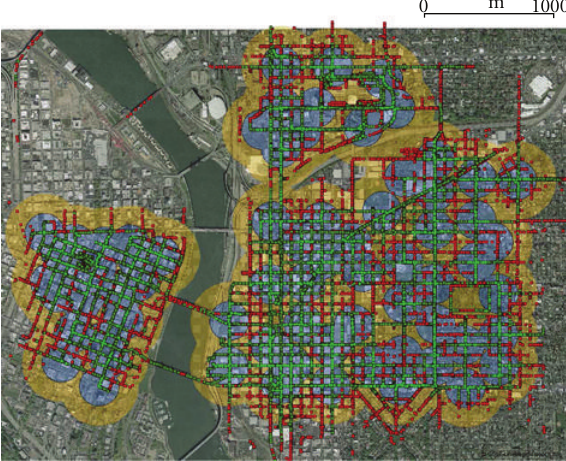
Figure 13: Measurements from “pdx/stumble” data set. Signal strength at measurement points is plotted as green (light) when it is strong to red (dark) when it is weak. The operator-assumed coverage is given as 500 (cid:5) circles centered at each AP, and the goal coverage area is given as larger 1000 (cid:5) circles centered at each